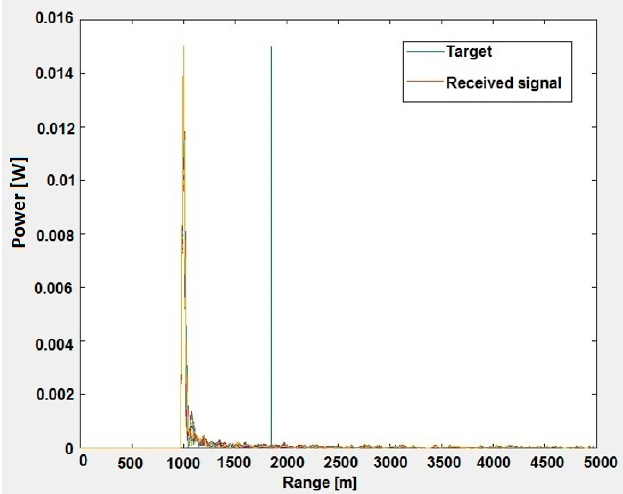
Figure 5. Values of signals received by the MIMO radar array as a function of range before STAP processing.